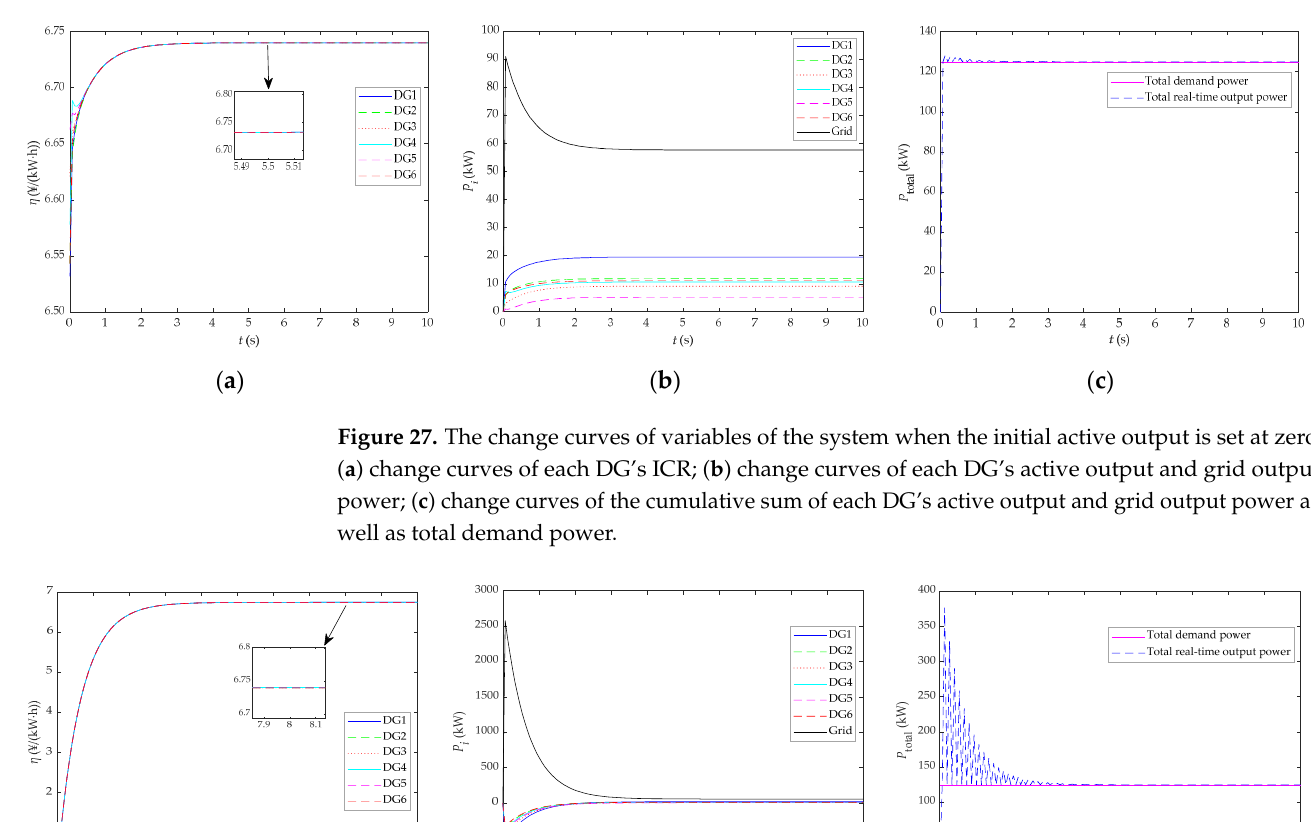
Figure 26. Comparison of steady-state optimal active output of each DG before and after the exiting of DG6.